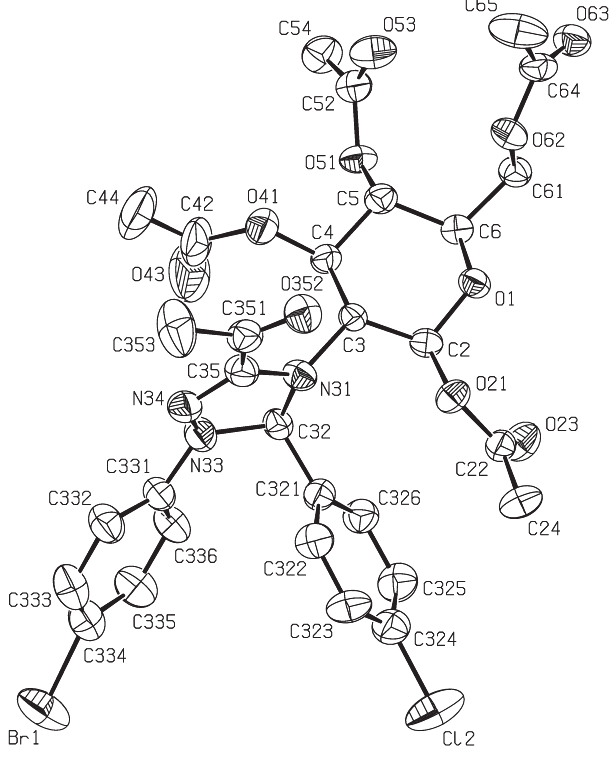
Table 2. Atomic coordinates and displacement parameters (in Å 2 )